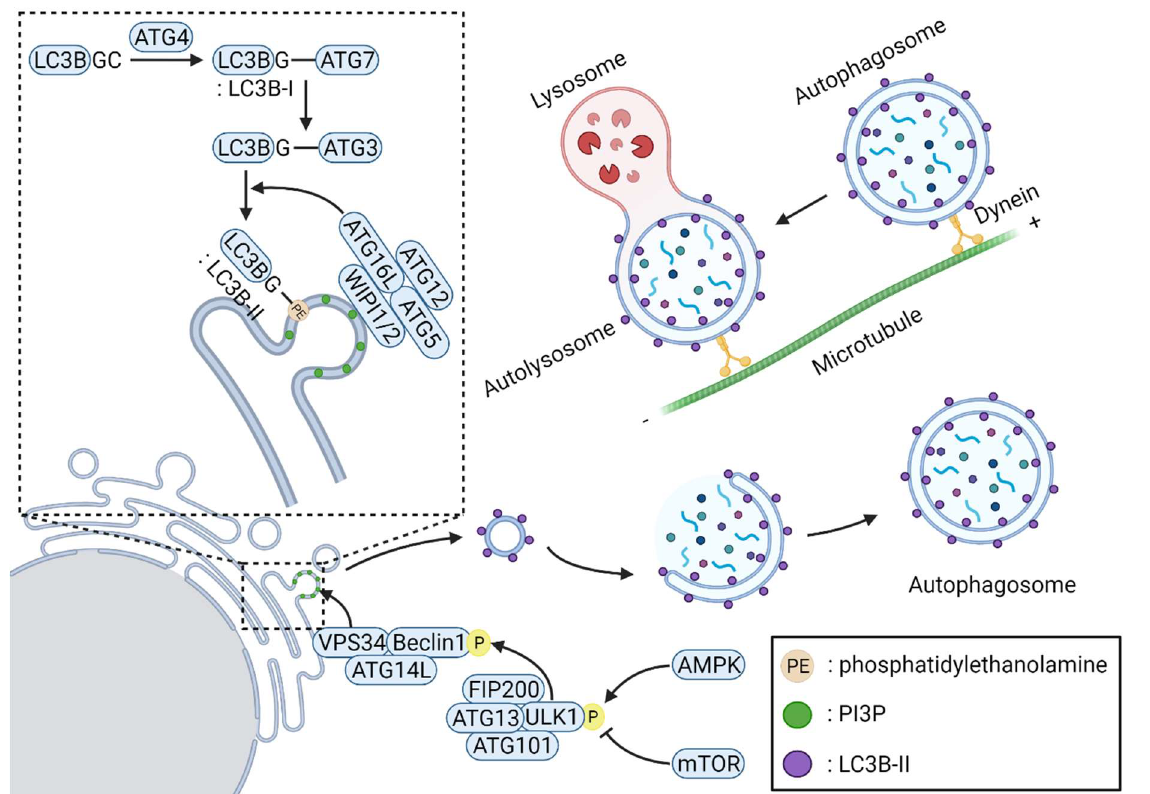
Figure 2. The most common autophagy process. Under nutrient-deficient conditions, increased AMP levels induce AMPK activation and AMPK-mediated activation of ULK1 complex (FIP200– ULK1–ATG13-ATG101). The ULK1 complex phosphorylates beclin-1, enabling the formation of the class III PI3K complex (VPS34–beclin-1–ATG14L). WIPI1/2 are recruited at the phagophore nuclea- tion site by binding with PI3P, which is generated by the class III PI3K complex. ATG4 protease cleaves the C-terminal end of LC3B to expose glycine (LC3B-I). LC3B-I is then incorporated into the phagophore nucleation membrane through lipidation with phosphatidylethanolamine (LC3B-II) via sequential interactions with ATG7, ATG3, and the ATG12–ATG5:ATG16L complex. The LC3B-II- positive phagophore is then elongated and forms an autophagosome. While elongated, the random cytosolic contents are captured in the autophagosome and degraded after the autophagosome ma- tures to an autolysosome.